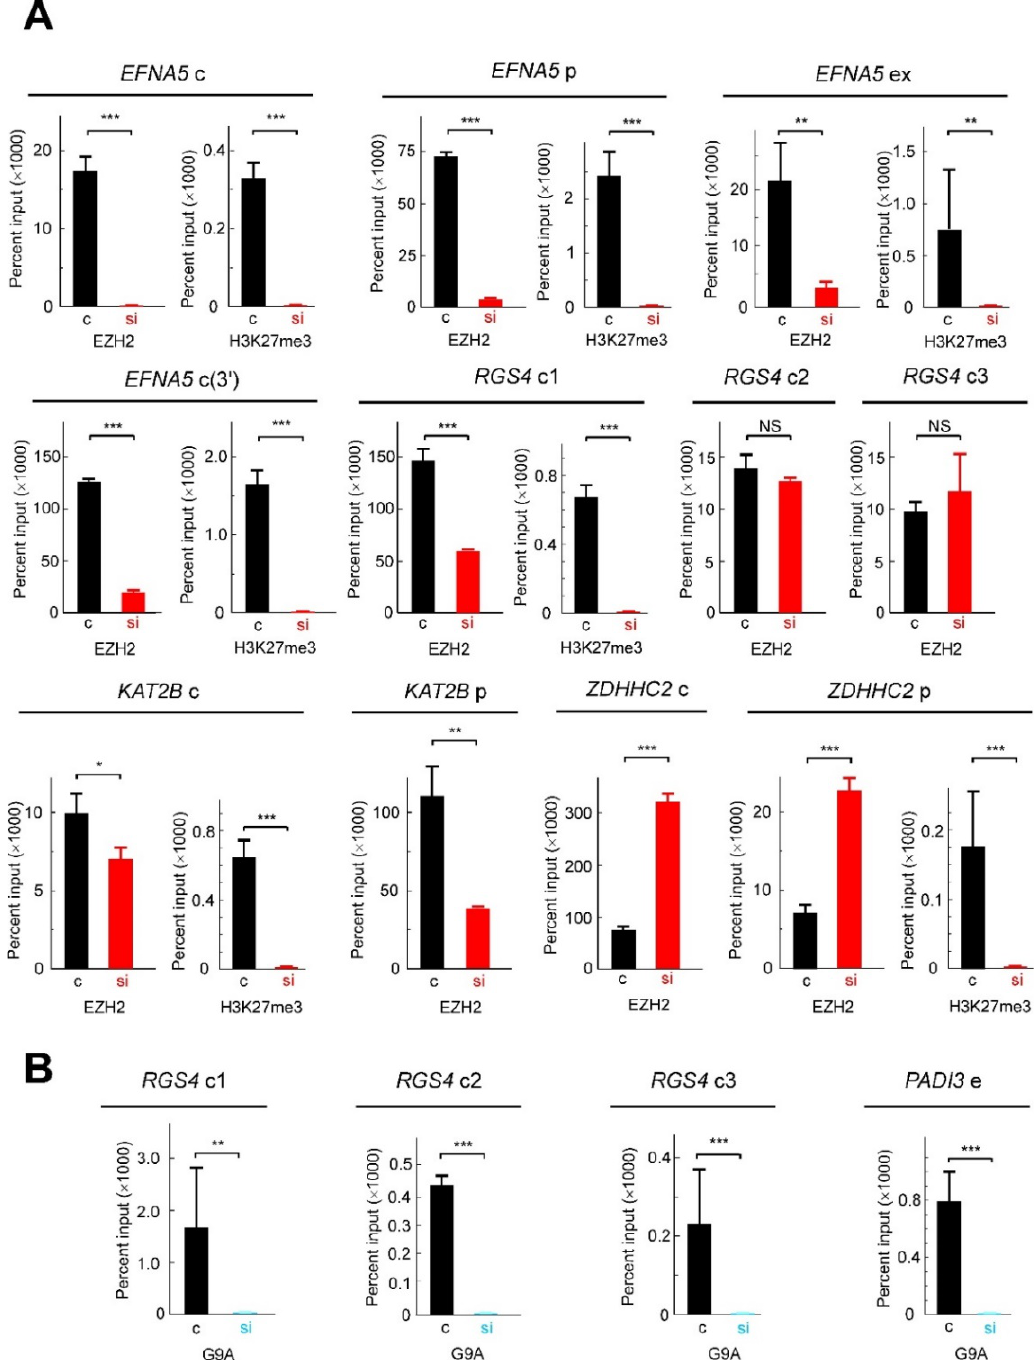
Figure 7. ChIP analysis of the presence of histone methyltransferases and of histone methylation in selected regions of genes affected by ZNF518B silencing. ( A ) Presence of EZH2 and the resulting mark (H3K27me3) in several regions of the selected genes. In some instances, the signal obtained in the immunoprecipitation with anti-H3K27me3 was too low to yield accurate results and the corresponding panel was omitted. ( B ) Presence of G9A in several regions of the selected genes. ChIP experiments were carried out with HCT116 cells in which ZNF518B was knocked down by transfecting with specific siRNA (si) or in control cells, transfected with scrambled siRNA (c), as indicated below the bar charts. The genes and their corresponding regions analysed (c, control regions; p , promoter; e, enhancer; ex, exon) are indicated over the charts. See Supplementary Figure S5 for the location of these regions. *, p < 0.05; **, p < 0.01; ***, p <